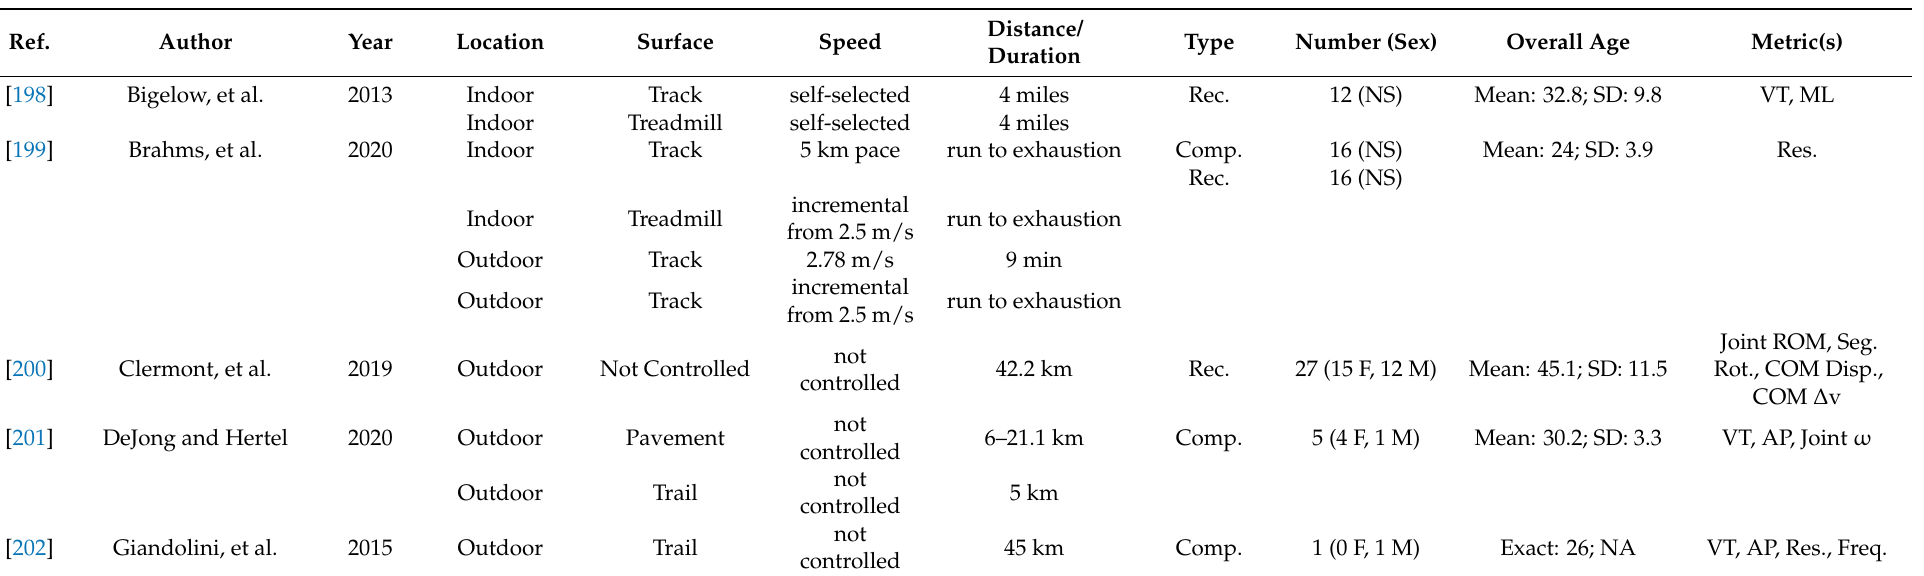
Table 4. Study characteristics where the analyzed distance is >1000 m over a single run.